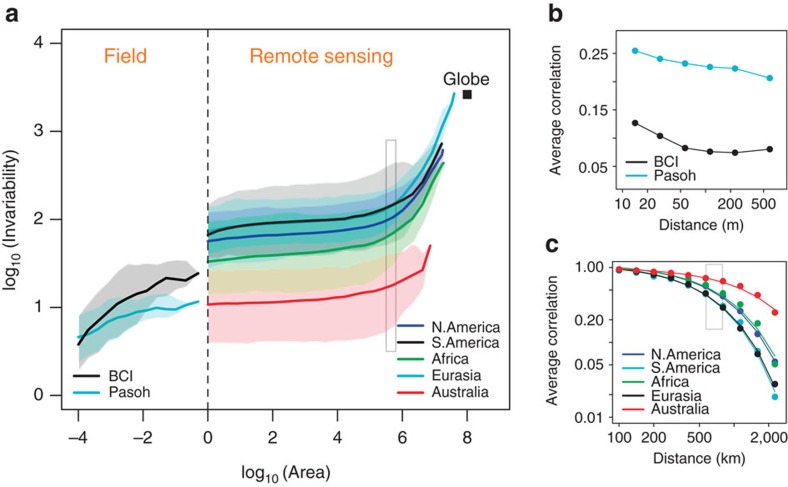
IARs and correlation–distance relationships of primary productivity.(a) IARs of primary productivity from plot to continental scales (unit of area: km2). Data are from field investigations of two 50-hectare tropical forest plots2829 (scale: 10−4–0.5 km2) and remote sensing NPP products from MODIS30 (scale: 1 km2 to globe). For each plot or continent, the curve shows median invariability of 500 replicates, and shades show 25 and 75% quantiles. The square shows the invariability and area of the entire globe. The vertical dashed line corresponds to 1 km2. (b) Correlation–distance relationships of primary productivity in the two tropical forest plots. Each point represents the average correlation between all subplot pairs (grid size: 10 × 10 m2) corresponding to some distance category. (c) Correlation–distance relationships of primary productivity in the five continents based on MODIS data. Each point represents the average correlation between all grid pairs (grid size: 1o × 1o) corresponding to some distance category. Curves are fitted exponential functions: ρ(d)=ρ1 × e−(d−1)/L (see Table 1 for parameter values). The grey box in c indicates the range of the parameter L for the four continents except Australia, which lies between 570 and 792 km. The grey box in a indicates the square of this range (L2), that is, between 3.3 × 105 and 6.3 × 105 km2.